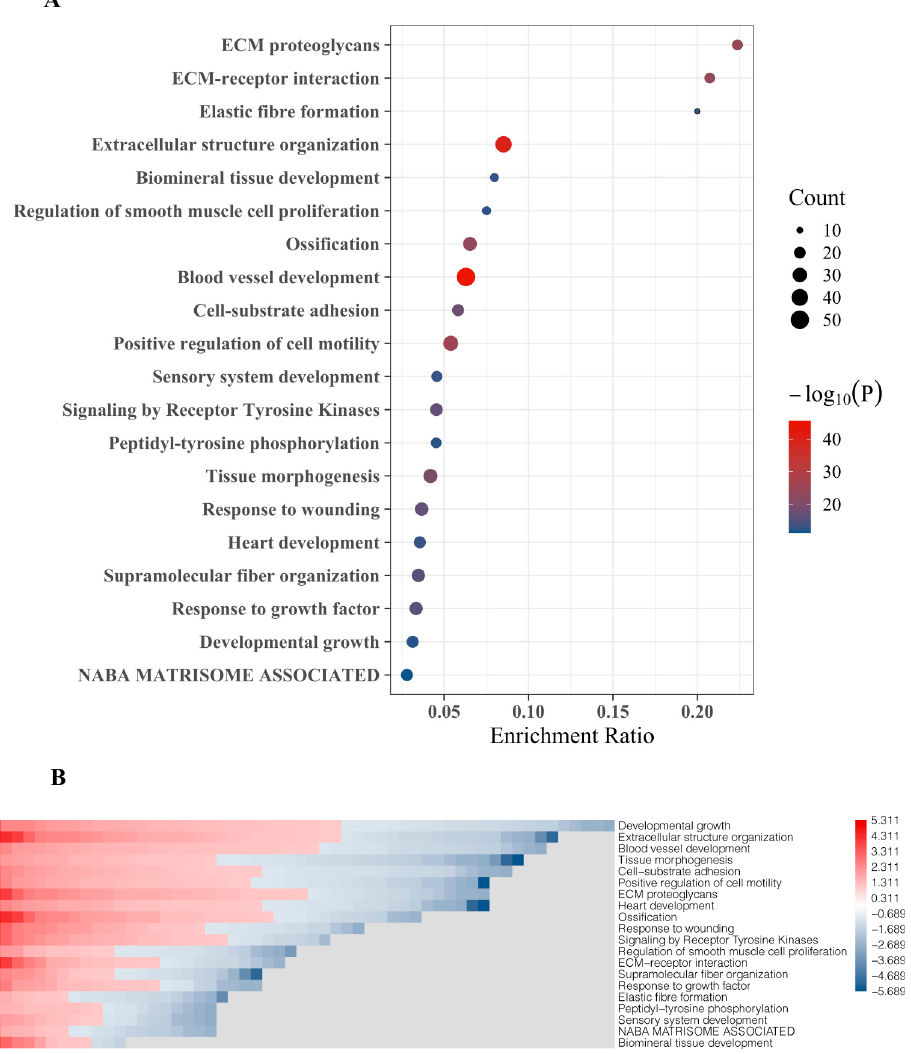
Figure 3. Gene ontology (GO) and functional enrichment of top 20 gene set involved in PCa BM. ( A ) Bubble chart representing the top 20 DEGs set enrichment based on their molecular activities obtained from Metascape. ( B ) Heat map representing GO and biological processes enrichment of DEGs obtained from Metascape and GO.